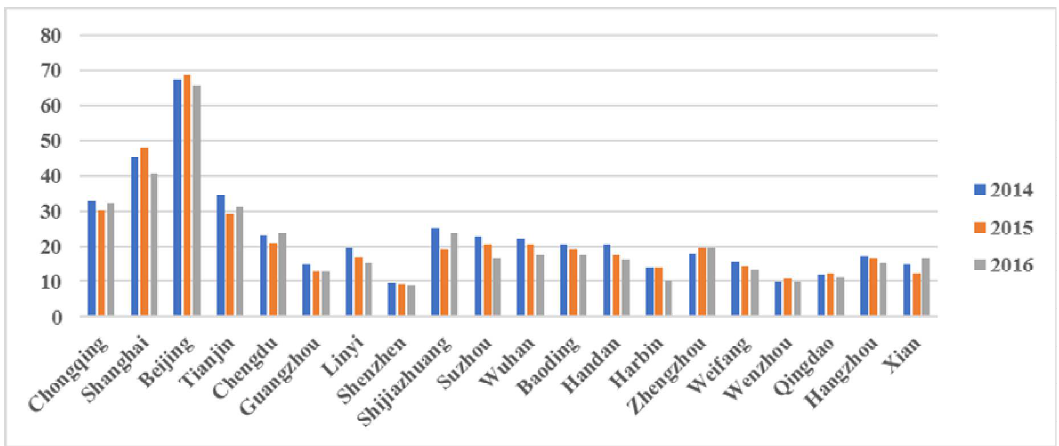
Figure 5. PM 2.5 -related economic losses as a result of health impacts in 20 Chinese major cities in the upper bounds during the period 2014–2016.